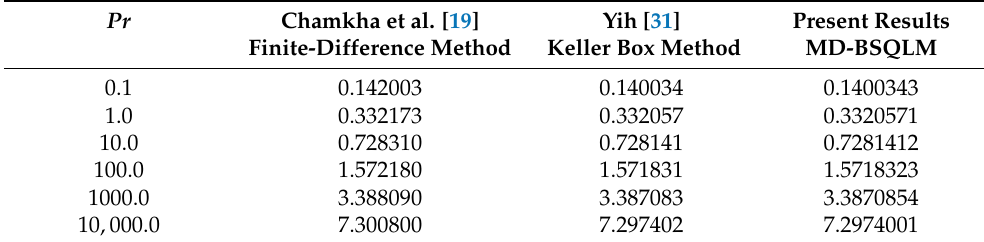
Table 2. Comparison of the values of − θ (cid:48) ( 0,0 ) for different values of Pr .